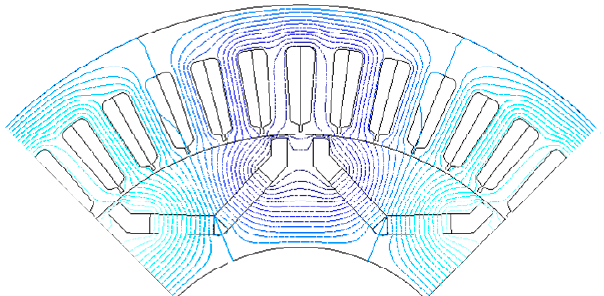
Figure 3. Flux line distribution in no ‐ load condition.